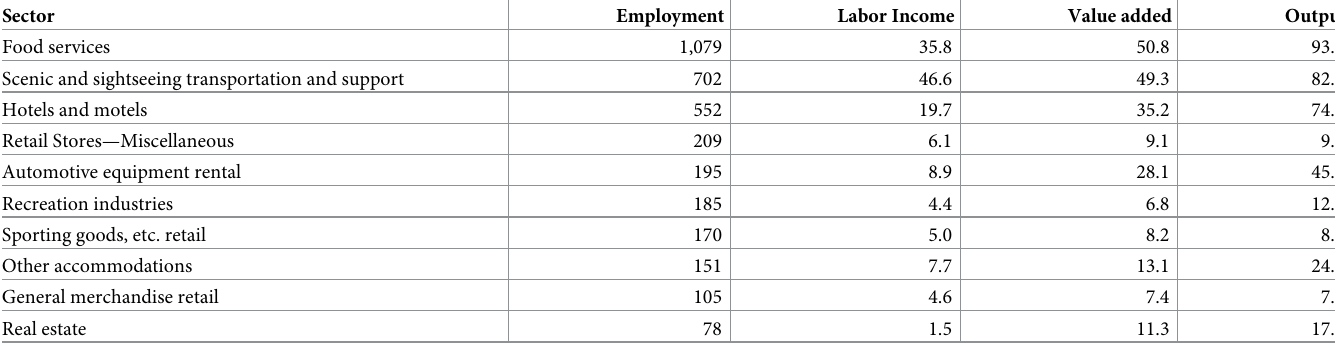
Table 6. Total economic impact by sector ranked by employment impact, 2021 US$ million.